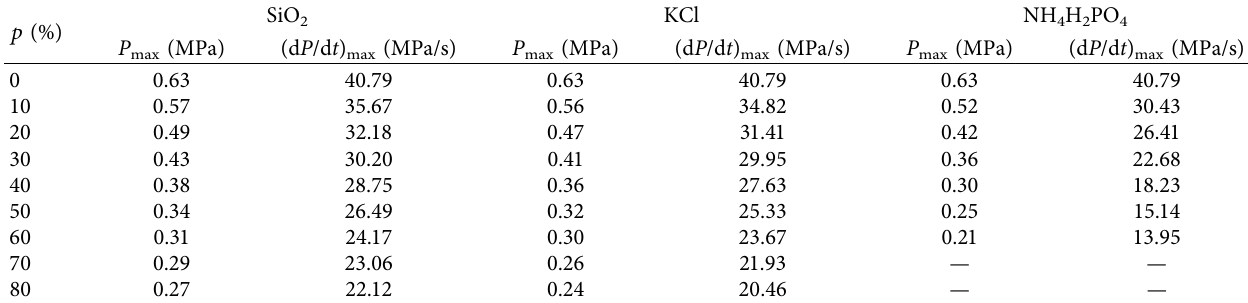
p , mass percentage of explosion suppression dust mixed with nonstick coal dust.